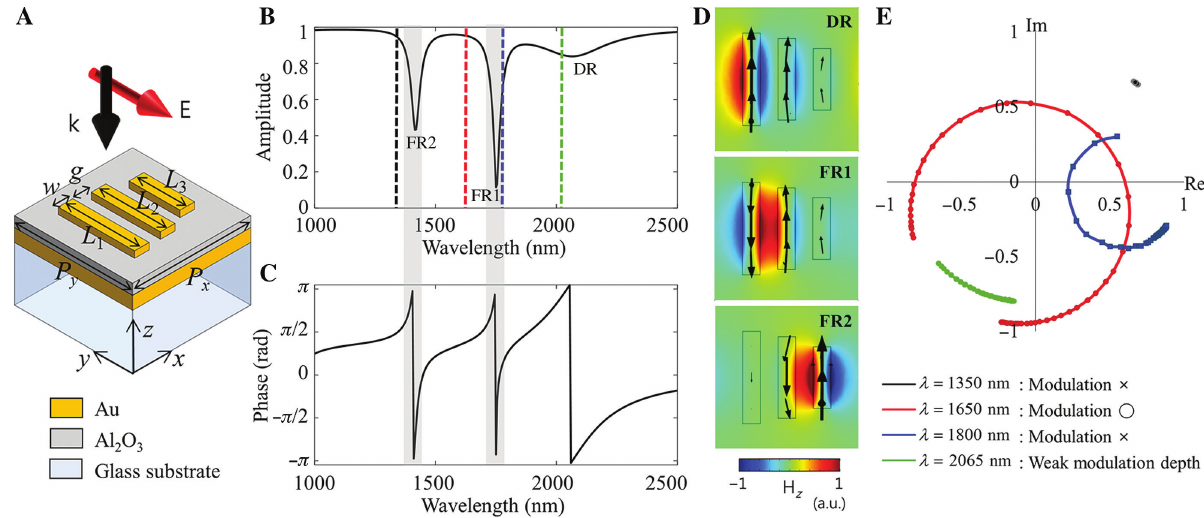
Figure 1: Proposed metasurface and its numerical analysis. (A) Schematic illustration of FRM in reflection form composed of triple gold nanorods with dielectric spacer above the gold film. Incident light has a y -polarized electric field. Amplitude (B) and phase (C) of the reflected light for the proposed metasurface. DR, FR1, and FR2 indicate the dipole, first Fano, and second Fano resonances in sequence. Gray shaded areas represent phase modulation at Fano resonances. Dashed color lines indicate the wavelengths to be used for analysis in (E). (D) Magnetic field distribution in z direction for each resonance condition with black arrows of induced current density. (E) Modulation characteristics for each wavelength near the DR, FR1, and FR2 regions in the complex plane when the nanorod length